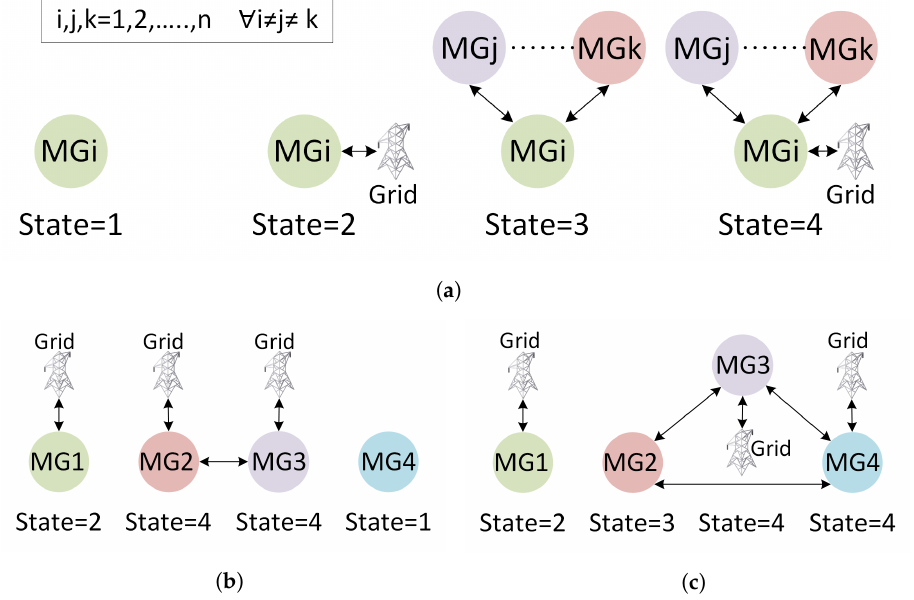
Figure 6. ( a ) States of an MG, ( b ) States in case 07, and ( c ) States in case 11. Table 1. Optimal cost and exchange powers of the